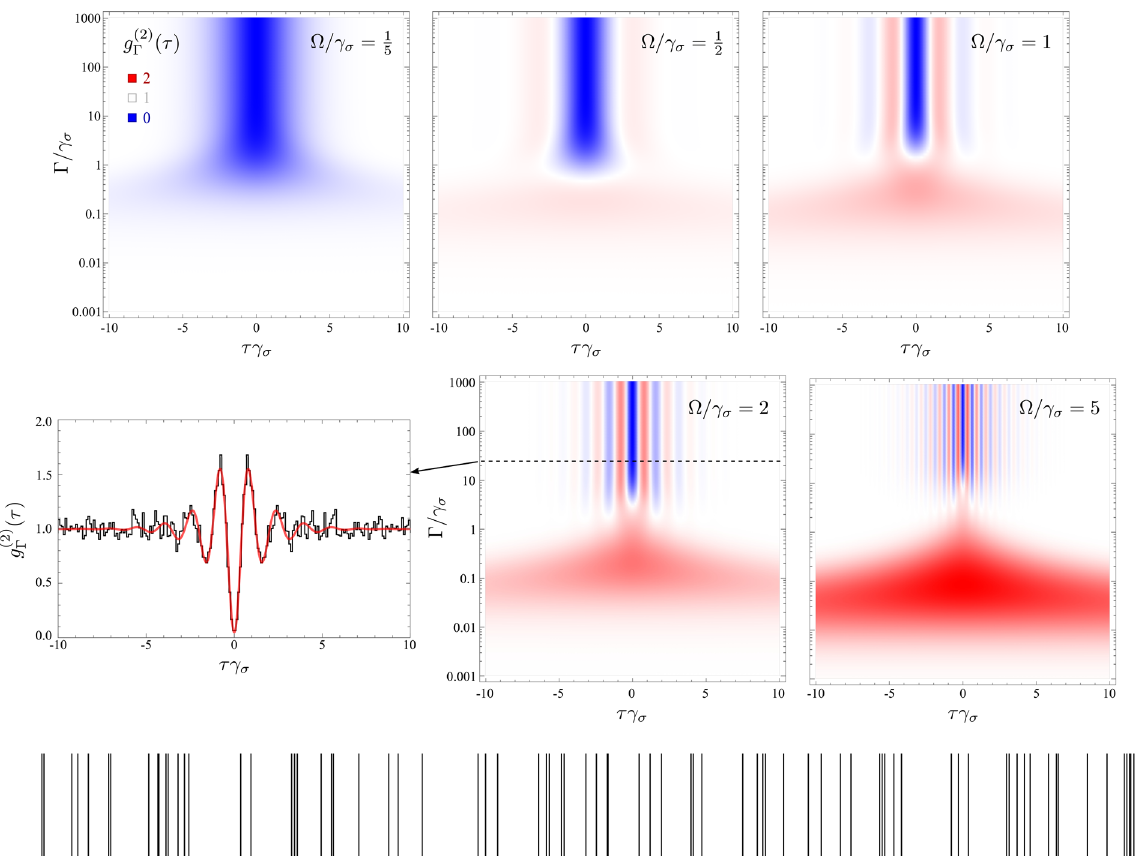
Figure 4. Frequency and time-resolved τ g ( ) (2) of a two-level system coherently driven, in its transition from Γ the Heitler to the Mollow regime (from left to right). At low pumping, one does not observe thermalization (bunching) with narrowing filters. Higher pumping brings both bunching, similar to the case of incoherent pumping, and oscillations. The bunching is observed only for moderately narrow filtering as extremely narrow filtering goes back to filtering exclusively the Rayleigh peak, with a resurgence of the Heitler effect and uncorrelated (or coherent) emission. Wide filtering overlapping the three peaks captures the Rabi oscillations. A Monte Carlo simulation of the case highlighted with the dashed line is shown through a small sample of clicks (bottom) and the autocorrelation function, compared to the theory prediction. There is a clear structure in the photon clicks, that is unlike any of the cases shown previously. The clicks correspond to the emission events of the operator c 3 in Eq.